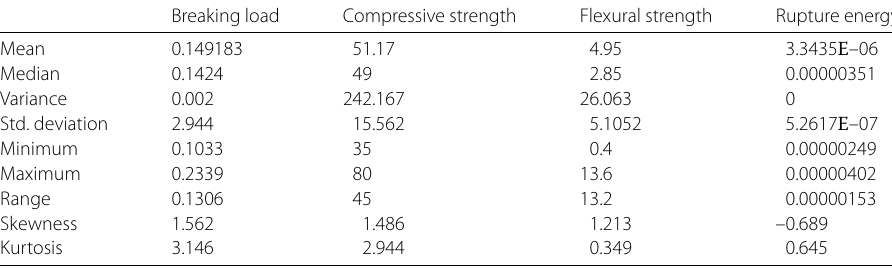
Table 3 The results of the descriptive statistics of the mechanical data Breaking load Compressive strength Flexural strength Rupture energy Mean 0.149183